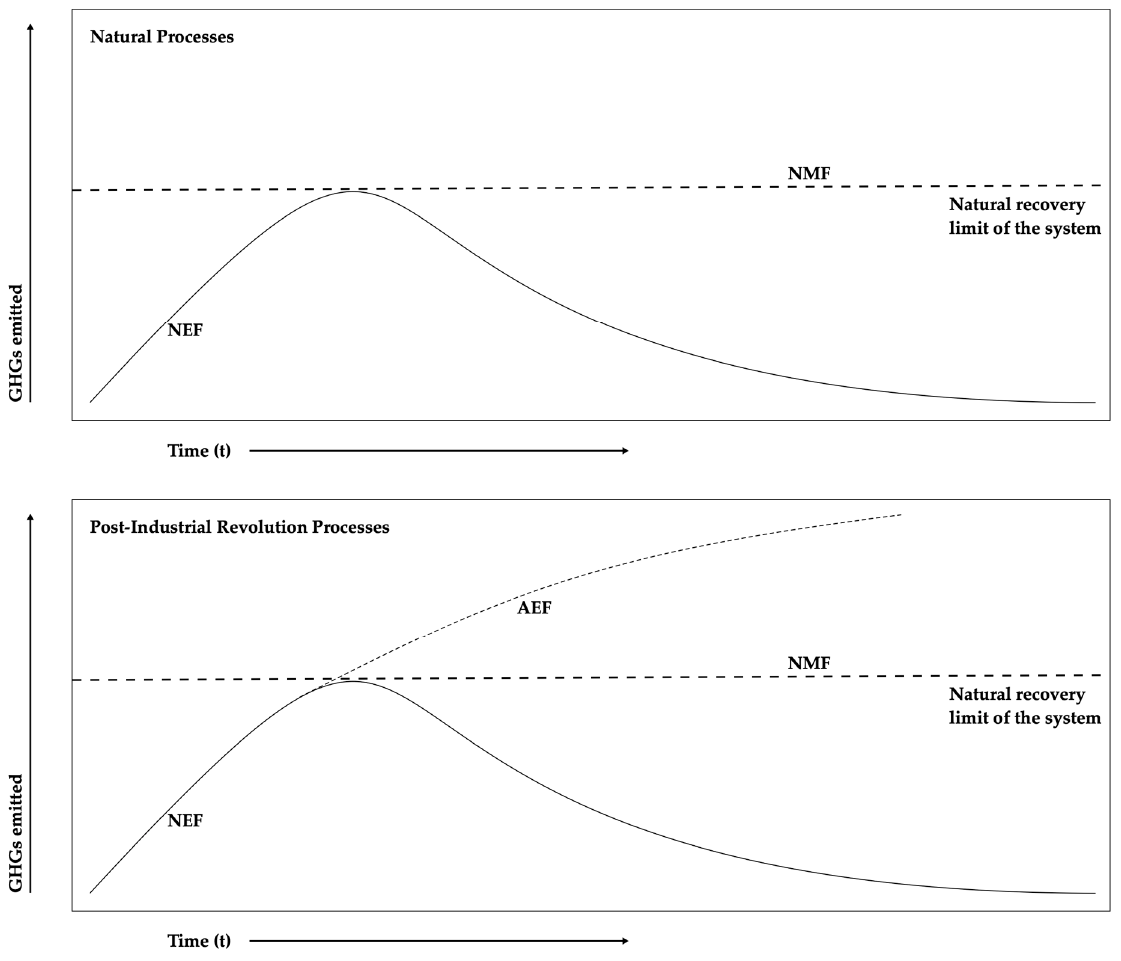
Figure 6. Evolution of the relationship between NEF and AEF with the natural capacity of the Earth system to counteract and neutralize the emission factors (NEF—Natural Greenhouse Gases Emission Factors; NMF—Natural Greenhouse Gases Mitigation Factors; AEF—Anthropogenic Greenhouse Gases Emission Factors).